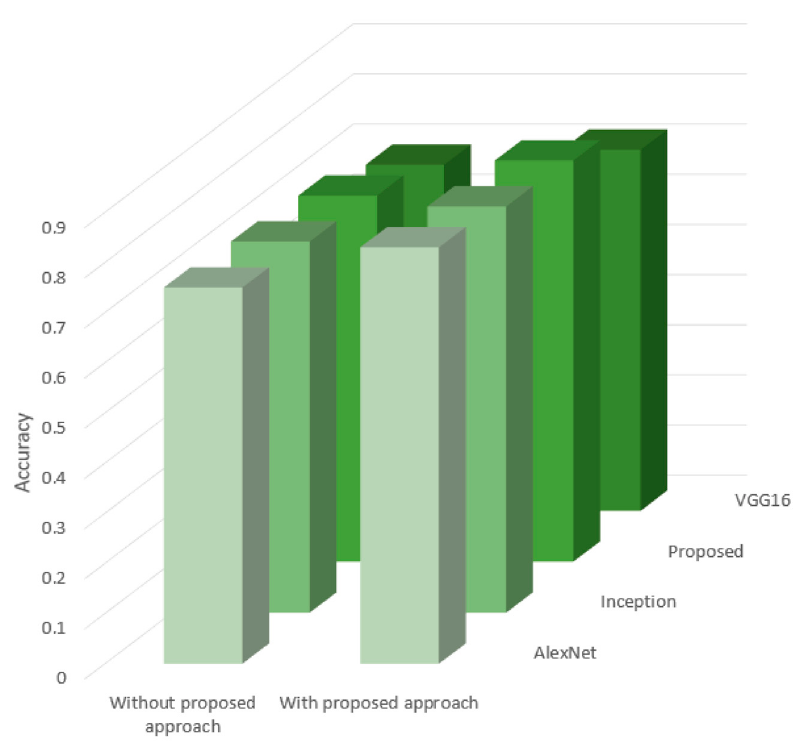
Figure 4. Comparison of the classic approach to image classification and